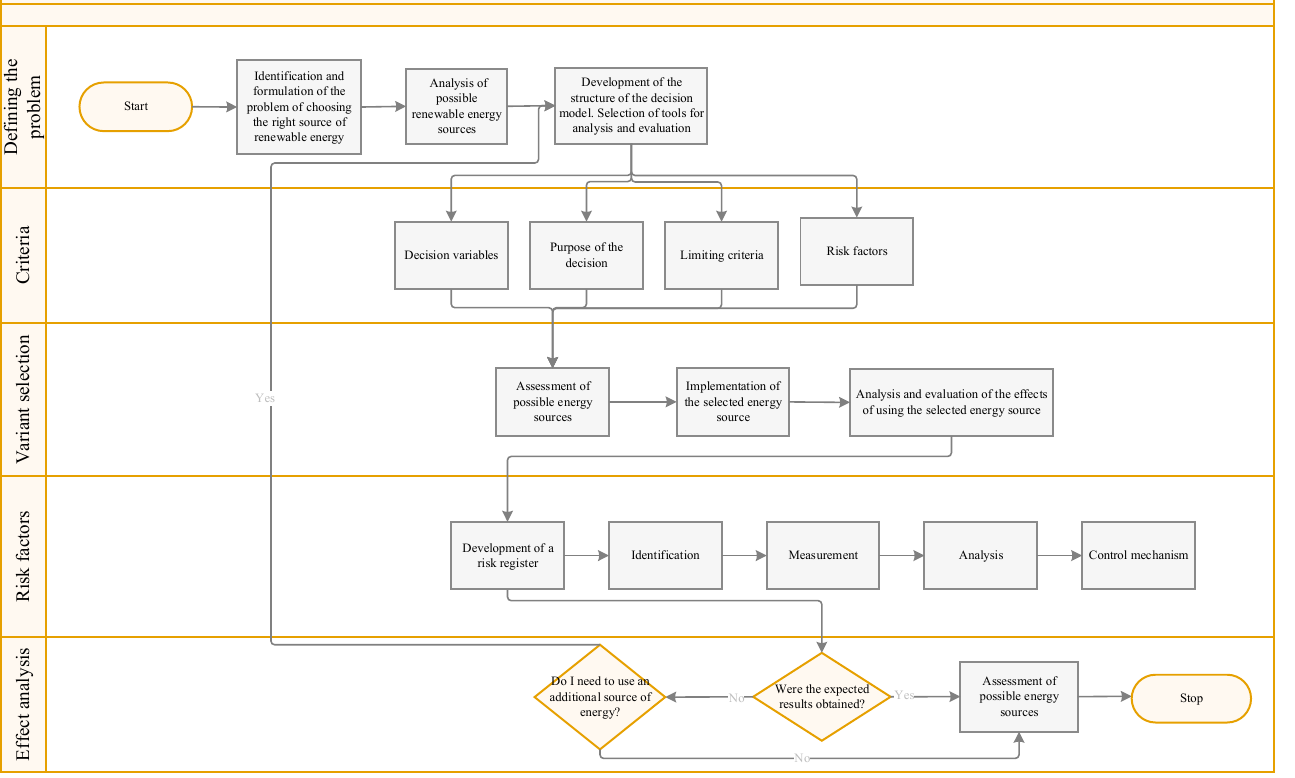
Figure 1. Diagram of the risk-related decision-making process around renewable energy sources. Source: Own study.